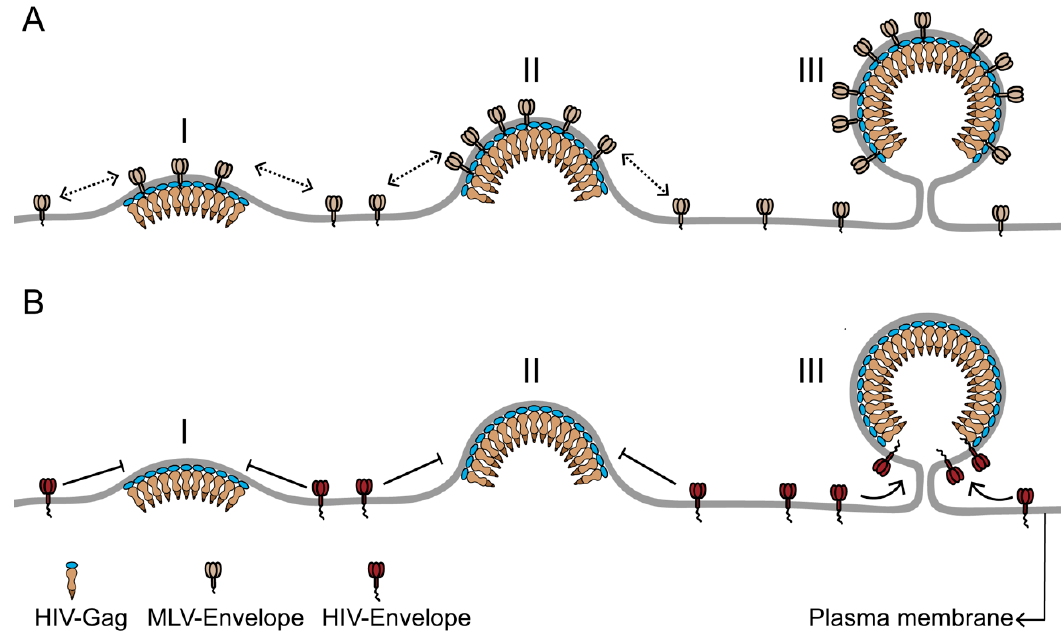
Figure 2. The differential incorporation of envelope proteins into the HIV membrane can result from differences in the time of recruitment to the HIV assembly site. ( A ) Murine leukemia virus envelope protein (MLV-Env) has strong affinity for the HIV assembly site due to its preference for ordered membrane phase and its small cytoplasmic domain. Consequently, MLV-Env is continuously recruited to the assembly site during the entire assembly process (stages I–III) and is enriched in the HIV membrane. ( B ) HIV envelope protein (HIV-Env), with a long cytoplasmic domain, is likely to be sterically excluded from the assembly site during the early and middle stages (stages I and II) of assembly. A low density of HIV-Env on the plasma membrane could also contribute to its absence from the assembly site during the assembly process. HIV-Env is recruited to the assembly site at the terminal stage of viral assembly (stage III), when the highly curved assembly site acquires a unique morphology, with a spherical bud attached to the PM by a narrow neck. The HIV Gag lattice at the end of the assembly process is arranged as a continuous but incomplete sphere in the virus head, with no Gag bound to the section of assembly site membrane adjacent to the neck of the viral bud. This Gag-free section of the assembly site membrane can accommodate the long cytoplasmic domain of HIV-Env without steric interactions. The limited Gag-free membrane space juxtaposed to the neck region could also help to limit the number of HIV-Env proteins in the viral membrane. The Figure is not drawn to scale.